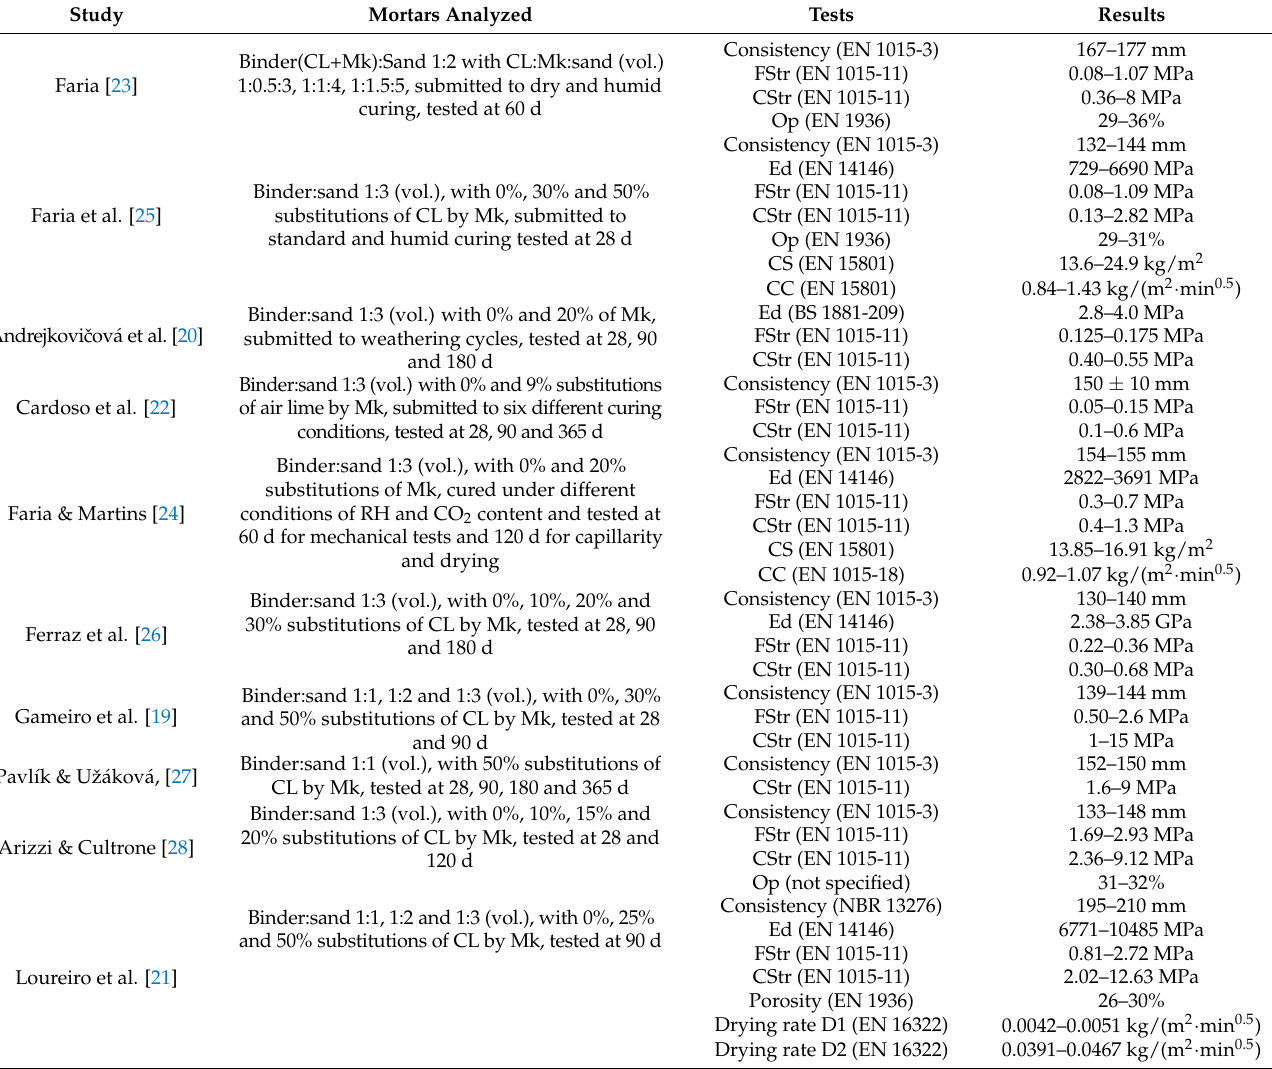
Table 1. Synthesis of air lime mortars with incorporation of metakaolin, test methods and